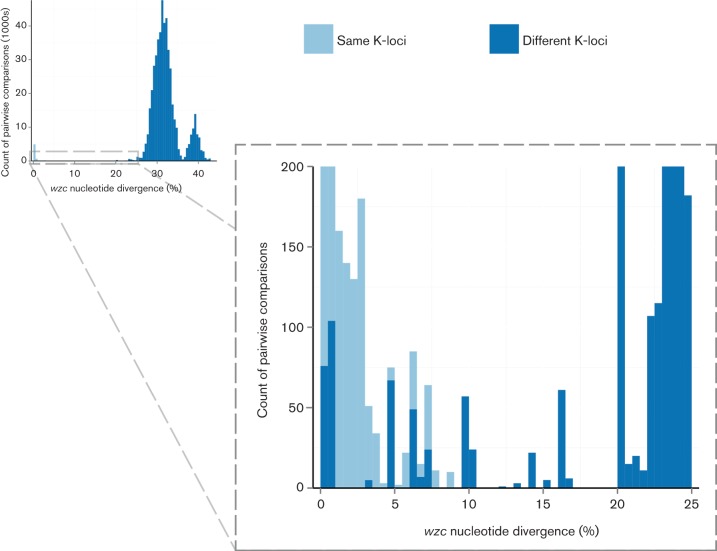
wzc nucleotide diversity. Barplots showing distribution of pairwise wzc nucleotide divergence for pairs of genomes with the same (light blue) or different (dark blue) K-loci. The inset shows a magnified view of the lower end of the distribution.